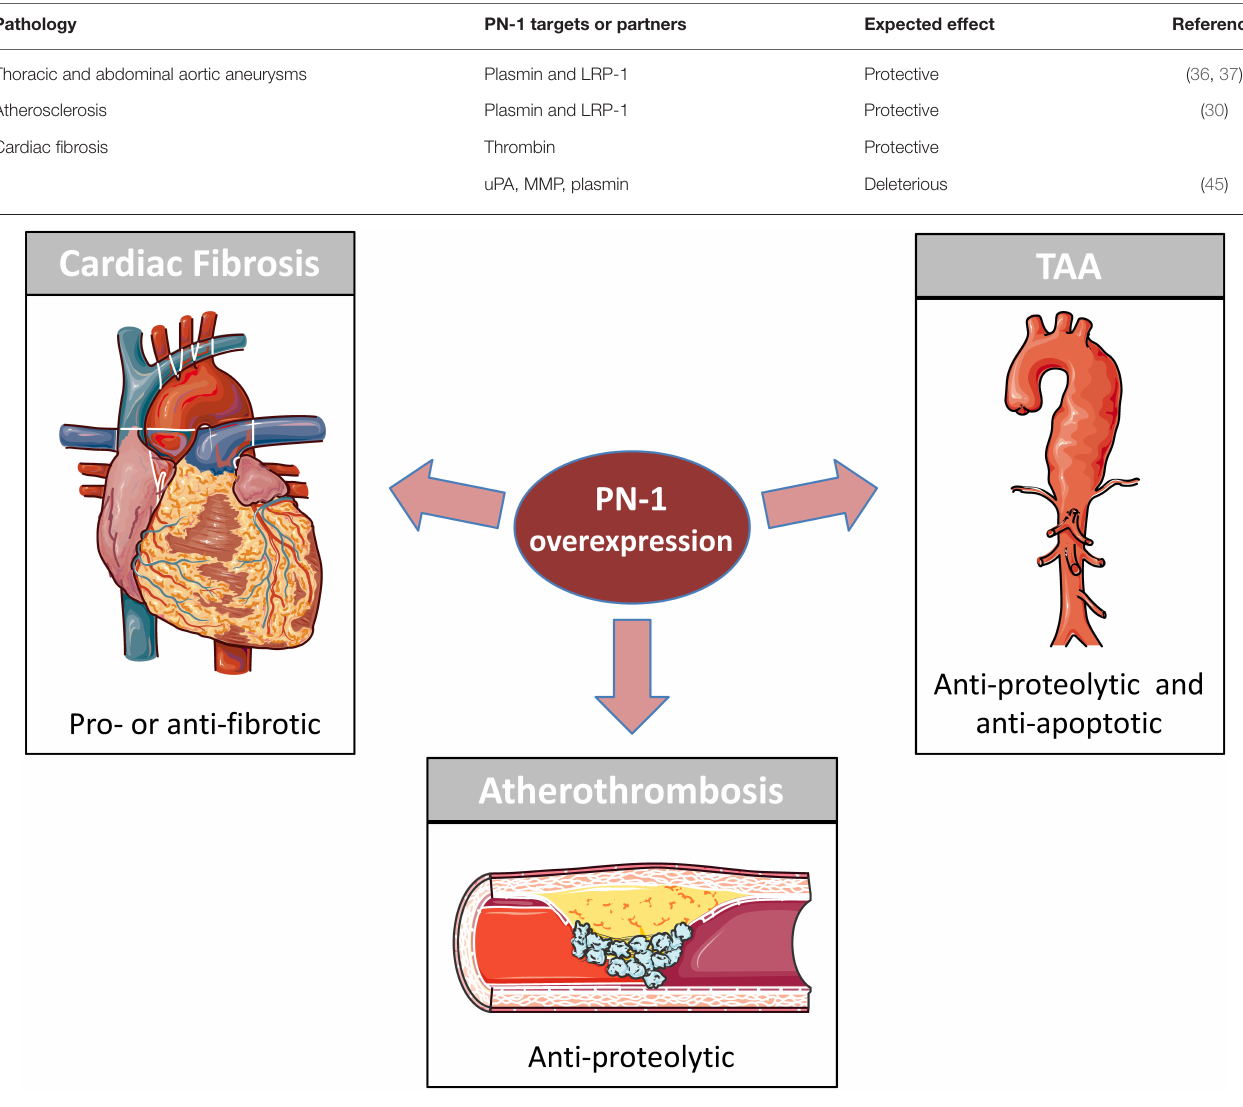
FIGURE 1 | PN-1 in cardiovascular disease. PN-1 is overexpressed in Atherosclerosis, Cardiac Fibrosis and Thoracic Aortic Aneurysm (TAA). Previous studies have shown PN-1 to be an important protective actor in atherosclerosis and TAA by reducing the impact of the proteolytic environment on the vascular cells. PN-1 is also involved in cardiac fibrosis but can be either anti-fibrotic and protective or pro-fibrotic and deleterious depending on its targets (see Table 1 ).